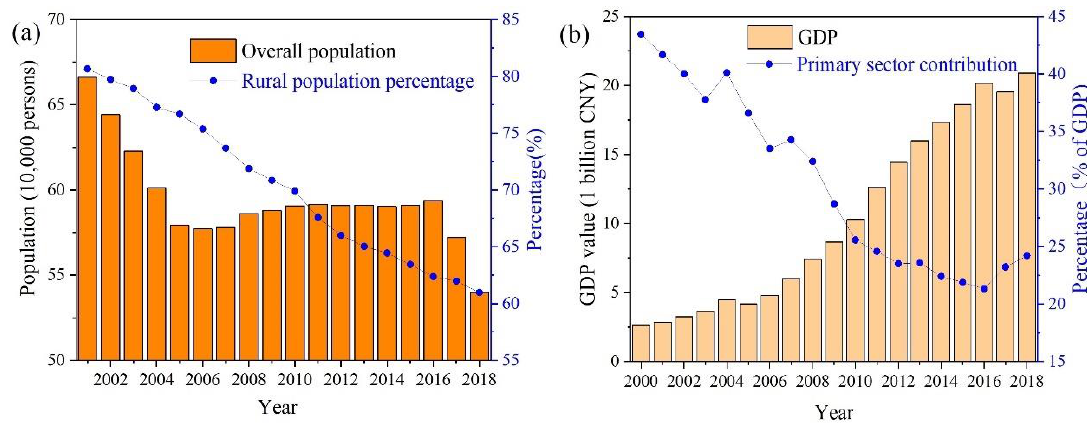
Figure 2. ( a ) The permanent population and rural population percentage in Rong County during 2001–2018 (source: [19]); ( b ) the time series of annual GDP (CNY 1 billion) and percentage of primary sector contribution (% of GDP) in Rong County during 2000–2018 (source: [34]).